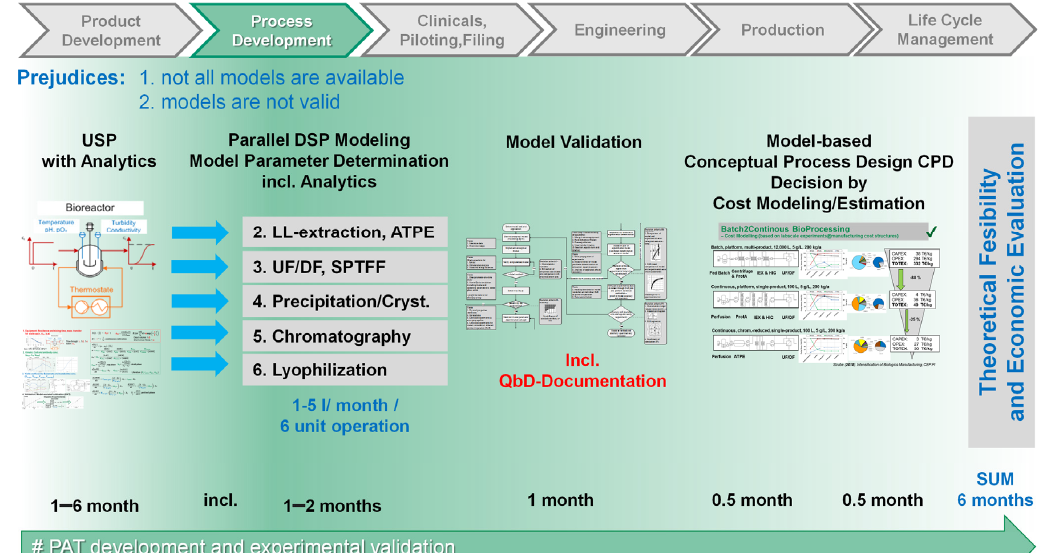
Figure 1. Process development strategy. The development of a new biologics manufacturing process starts with screening for optimal cultivation conditions in upstream processing (USP). Samples from optimization experiments are used for establishing Process Analytical Technology (PAT), partial least squares regression (PLSR), and physicochemical process- models in USP. In parallel first downstream processing (DSP)-optimization experiments are performed. Models have then to be validated according to published validation workflows that ensure accuracy and precision of modeling